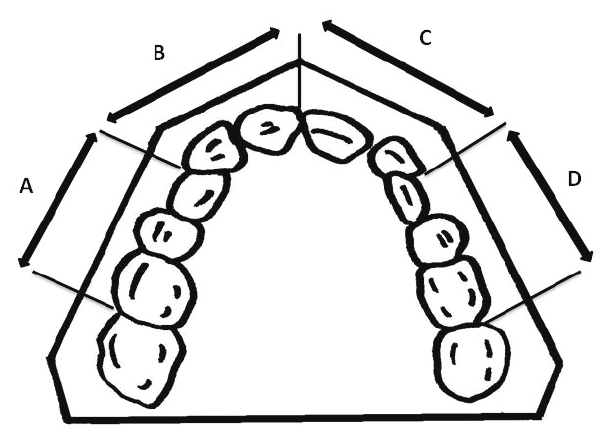
Figure 1. Dividing the dental arch into four segments for calculation of available space based on the method described by Sharma et al. 15